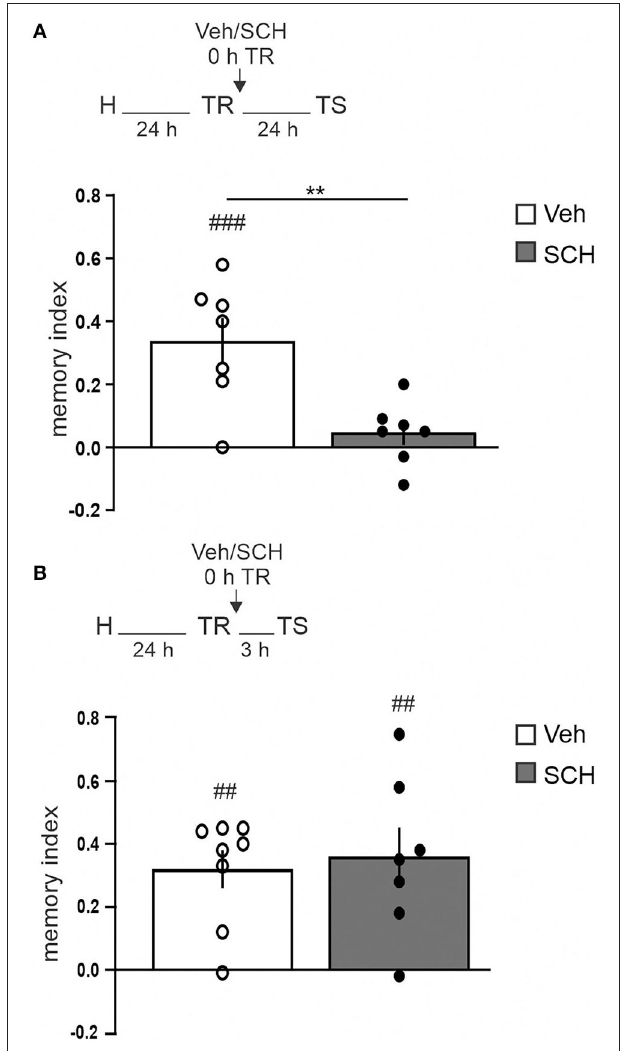
FIGURE 2 | aRSC requires D1/D5 activity for object recognition memory consolidation. Saline (Vehicle, Veh, white bar) or D1/D5 antagonist (SCH23390, SCH, gray bar) was infused into aRSC immediately after training. Graphics show the discrimination index from animals tested (A) 24h or (B) 3h after the training session. Data are expressed as mean ± SEM. ** p < 0.01, Veh vs. SCH, two-tailed Student’s t -test; ## p < 0.01, ### p < 0.001,